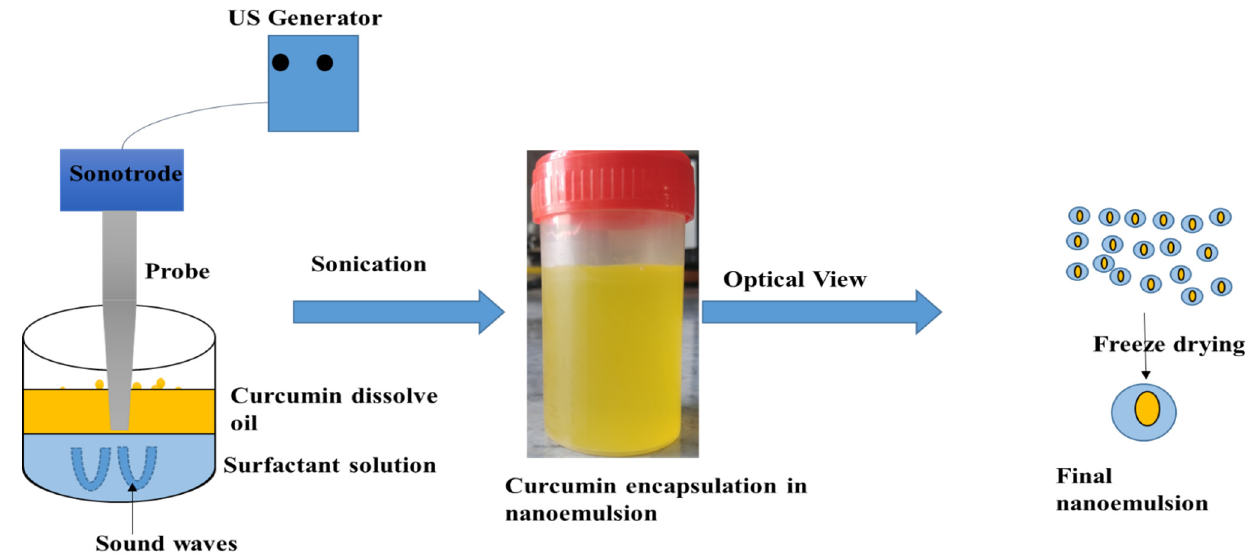
Figure 8. Schematic diagram for preparation of curcumin nanoemulsion using